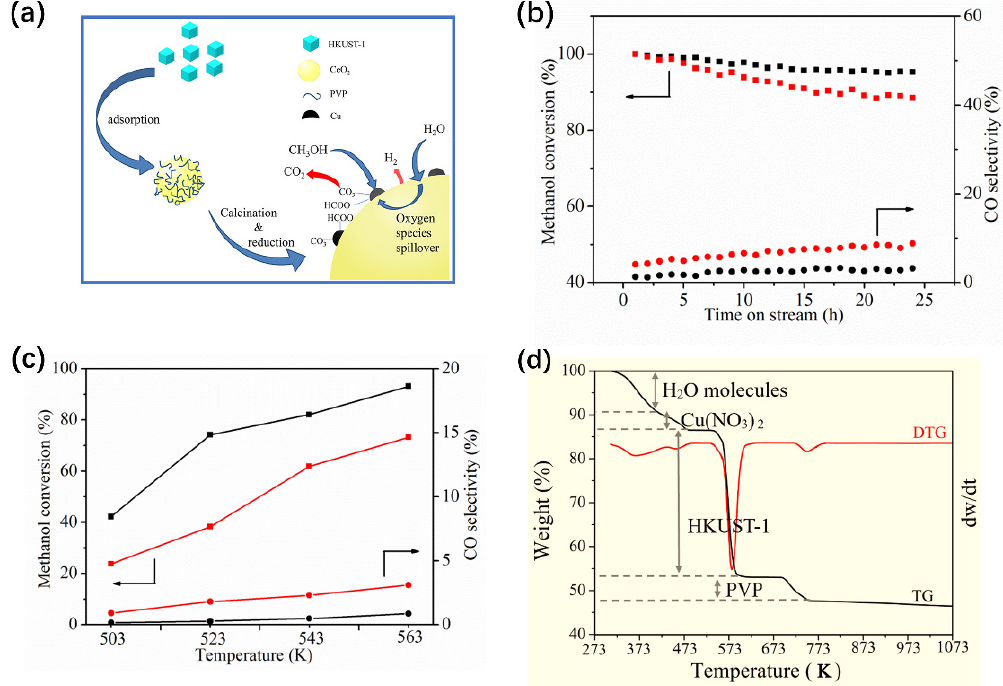
Figure 10. MOF-derived CuO-CeO 2 catalysts for methanol steam reforming: ( a ) Methanol steam reforming reaction mechanism over MOF-derived CuO-CeO 2 catalyst; ( b ) stability testing of CuO- CeO 2 (black dots) and CuO-CeO 2 -I (red dots), (square: methanol conversion; circle: CO selectivity); ( c ) catalytic performance of CuO-CeO 2 (black line) and CuO-CeO 2 -I (red line) as a function of temperature, (square: methanol conversion; circle: CO selectivity); and ( d ) TG-DTG plots of the HKUST-1-CeO 2 composite, (black line: thermogravimetric curve, red line: differential curve of thermogravimetric curve). Reproduced with permission [149]. Copyright Elsevier, 2020.